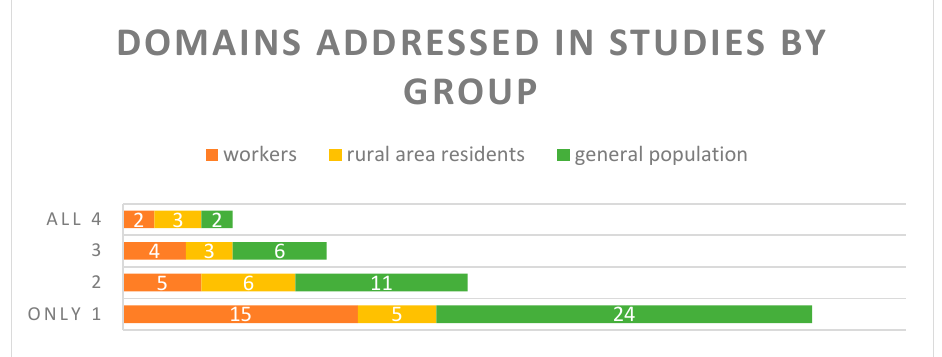
Figure 1. Domains addressed in studies by group.